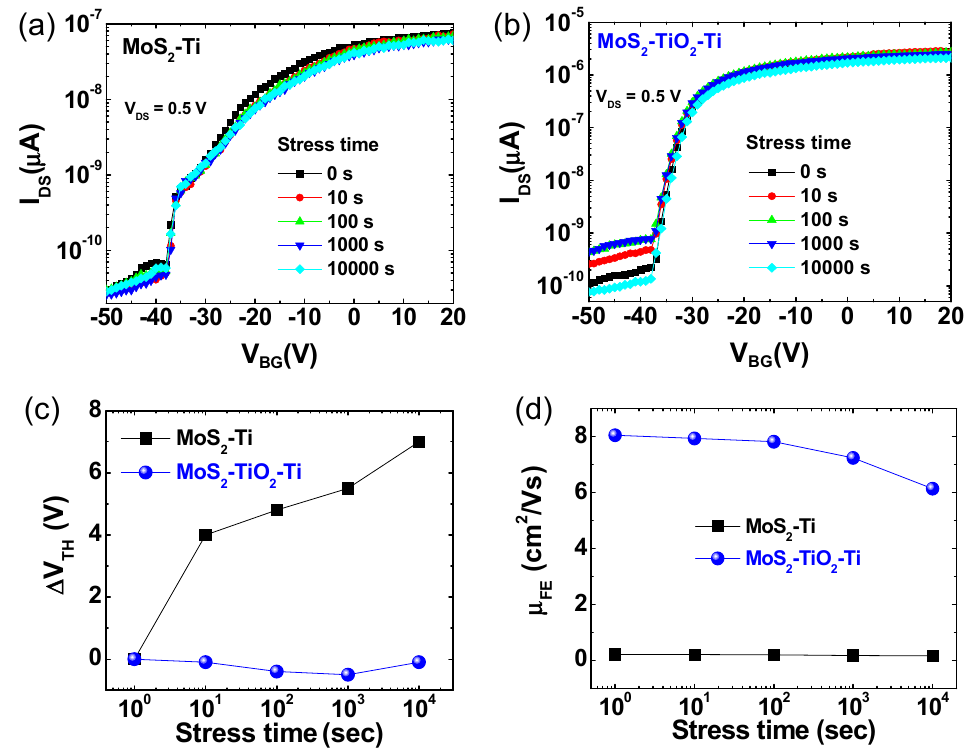
Figure 3. Transfer curves (I DS -V BG ) of MoS 2 FETs ( a ) without TiO 2 and ( b ) with a TiO 2 layer during a 10,000 s gate-bias stress measurement at room temperature. The summary of ( c ) the ∆ V TH shift and ( d ) the μ FE change as function of stress time for MoS 2 -Ti and MoS 2 -TiO 2 -Ti. Overall, the μ FE of MoS 2 -TiO 2 -Ti device was higher than that of the MoS 2 -Ti device. After 10,000 s stress time, the μ FE was reduced from 0.22 to 0.17 cm 2 /Vs for the device without a TiO 2 layer and from 8.05 to 6.14 cm 2 /Vs for the device with a TiO 2 layer. Approximately, 25% of the μ FE reduction was observed for both cases.